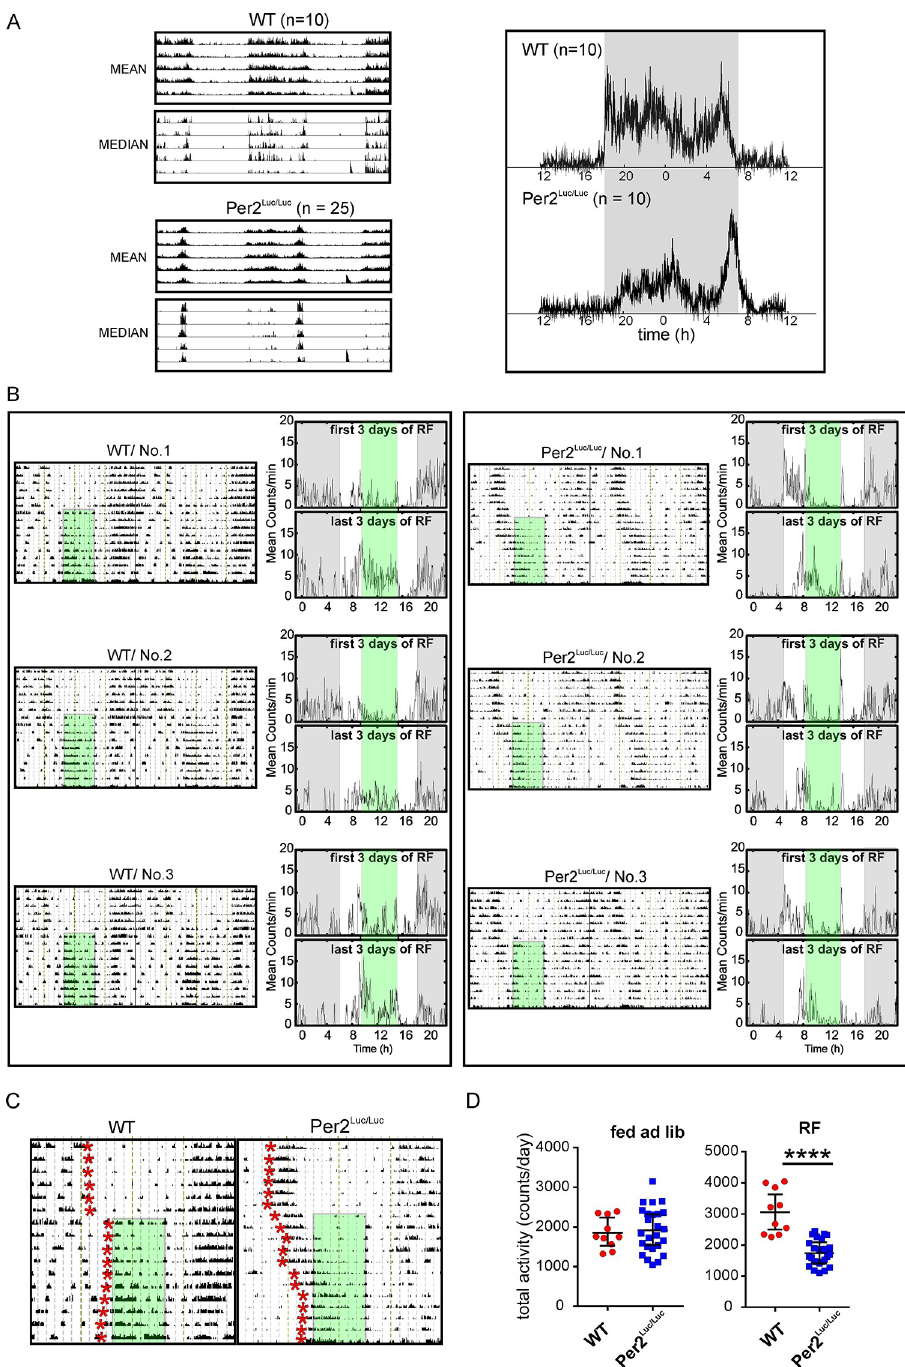
Fig 6. Entrainment of OFA with restricted food availability during the subjective day (RF). A. Activity profiles of mice entrained to LD12:12 cycles. Left panels: group-accumulated actograms of WT (n = 10) and mPer2 Luc/Luc (n = 25) mice calculated as activity average (upper pair) or median (lower pair). The short activity bout (red arrow) during the last inactive period (at ZT9) is the reaction to the first food removal at the beginning of the RF schedule. Right panels: group-composite daily activity profiles for 10 animals/genotype over the interval shown to the left. B. Representative double-plotted activity records from WT and mPer2 Luc/Luc animals in LD and exposed to RF for 10 days (green area). For each animal the raw activity recordings are shown in the actogram on the left, and the average activity profiles for the 1 st three days and last three days of RF are shown on the right. C. Representative single plotted actograms (from records in B, No.1 WT and No. 1 mPer2 Luc/Luc ) demonstrate genotype specific differences in the mode of